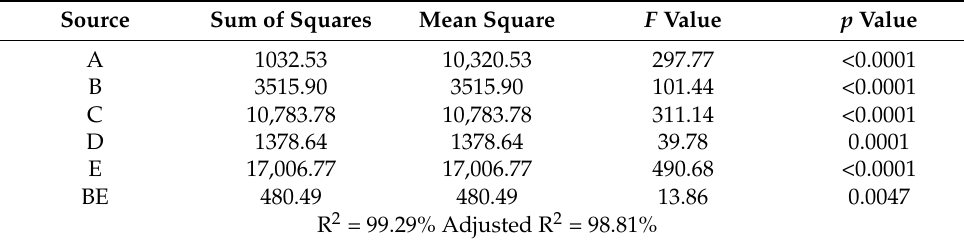
Figure 5. The cell viability of hWJMSCs cultured on the scaffolds for 24 h. The asterisk (*) indicates p < 0.05 versus control. Table 7. ANOVA analysis of the cell viability.